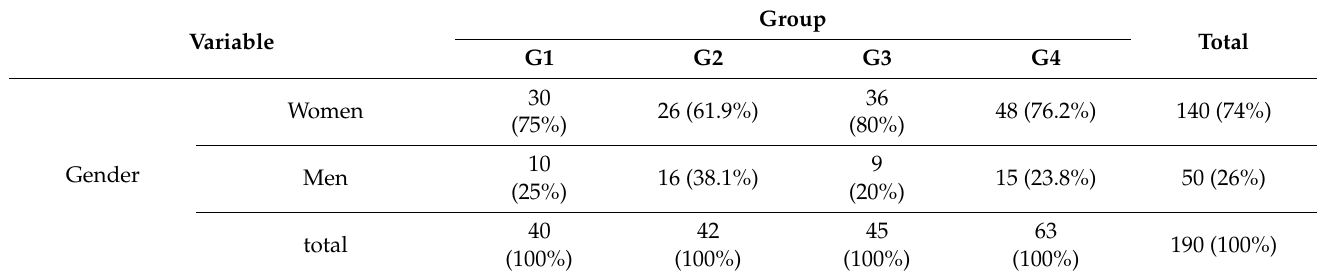
Table 1. Sociodemographic data of patients in the groups G1, G2, G3 and G4.